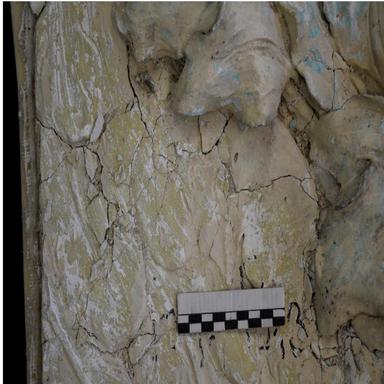
Area in the fragment of the wings of the eagle in which the finishing layer is completely detached from the ground layer.